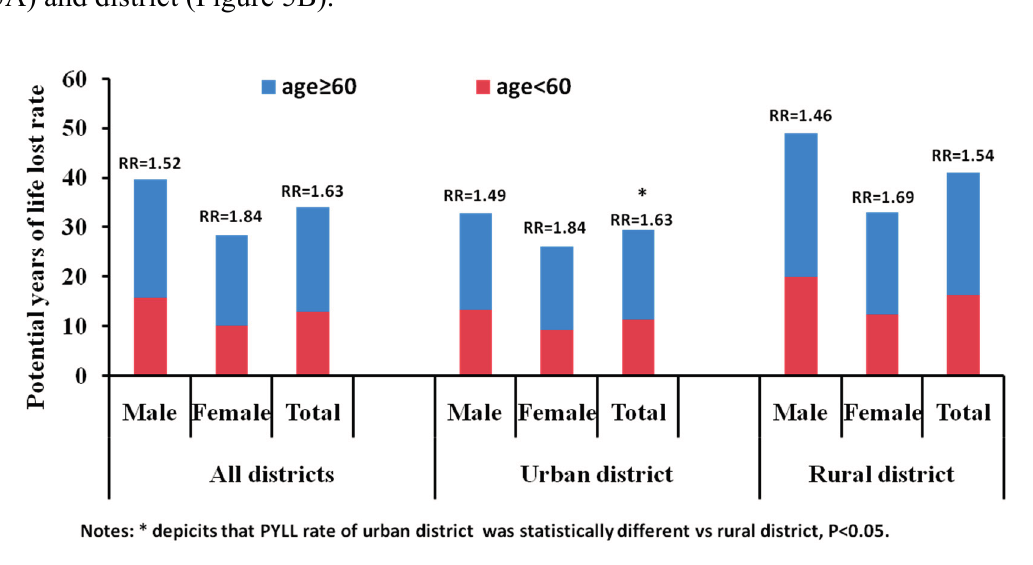
Figure 4. Potential years of life lost rate for the elderly ( ≥ 60 years) and young (<60 years) populations in China, 2005–2011.